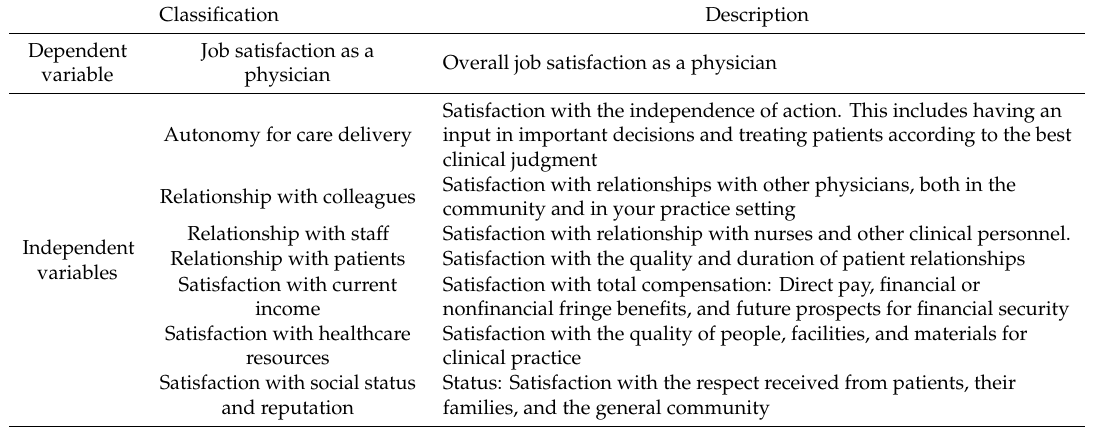
Table 1. Description of